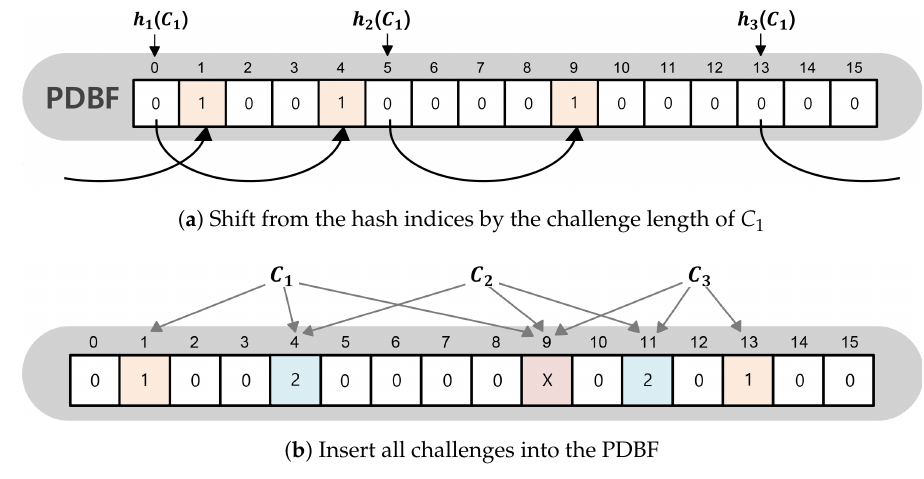
Figure 2. Programming procedure for a